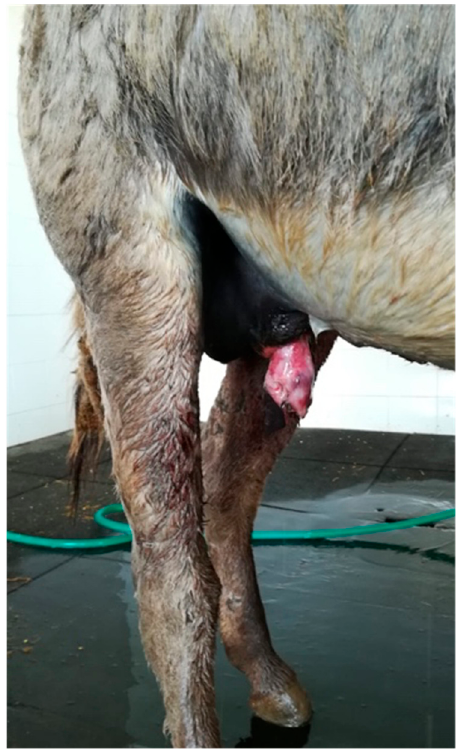
Figure 3. Appearance of the preputial laceration on admission (clinical case 1). The underlying penile tunics were not involved.